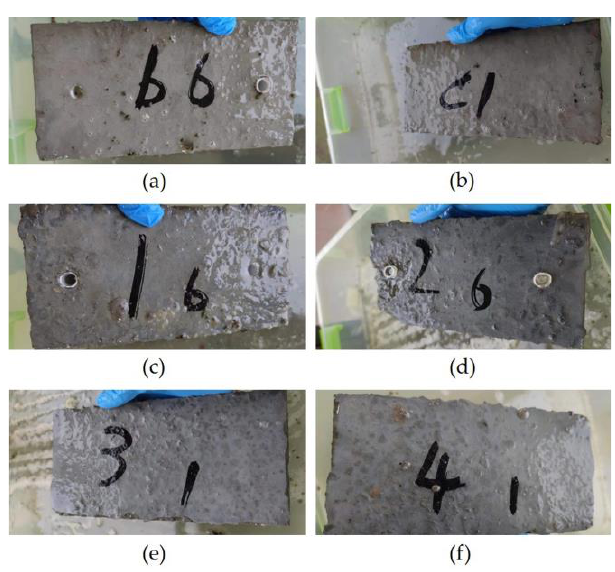
Figure 8. Water surface conditions.